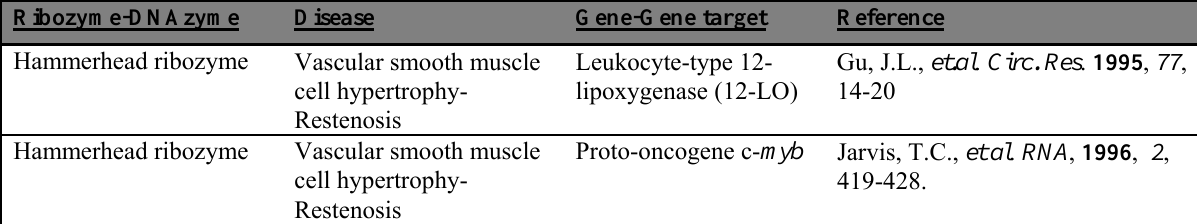
Table 1. Ribozymes and DNAzymes used for the elimination or repair of pathogenic gene expression involved in different muscle and brain